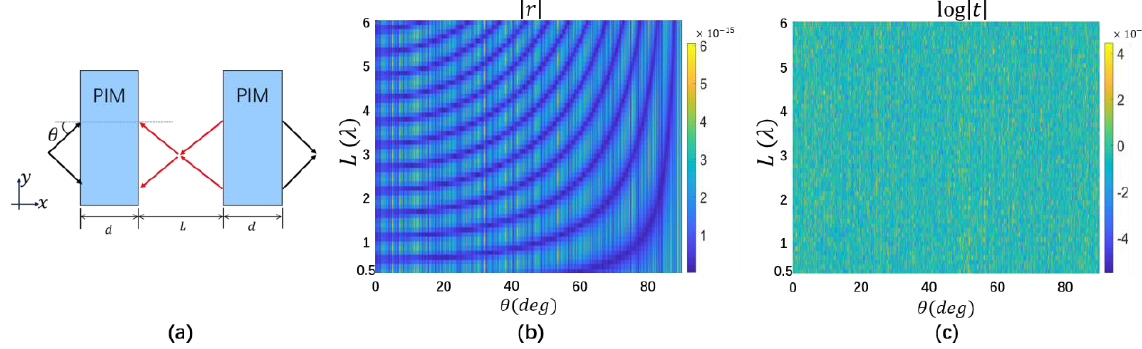
Figure 3. ( a ) Schematic diagram of negative refraction based on two identical PIM slabs. ( b )The magnitude of the transmission coefficient and ( c ) the logarithm of the amplitude of the transmittance coefficient as a function of the angle of incidence θ and the spacing L between the two slabs. are immersed in the air and the four black vertical lines indicate the outer boundaries of the left and right PIM slabs, respectively. The incidence angle is arbitrarily taken as 30 ◦ . The black arrows indicate the direction of the energy flow in each